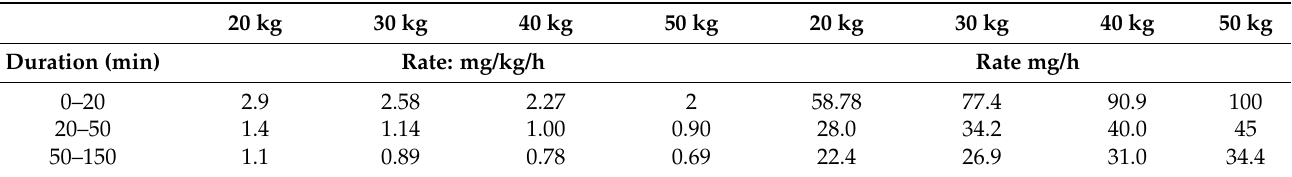
Table 2. Dexmedetomidine infusion rate required to achieve a target effect of bispectral index of 73 in a male child of 6 years of age and height of 115 cm. The target concentration was 1 µ g/mL. The loading dose was administered over 20 min. Subsequent infusion rates were altered at 20 min and 50 min in order to maintain the target concentration. Simulation for rate determination performed using pharmacokinetic parameters from Morse et al.